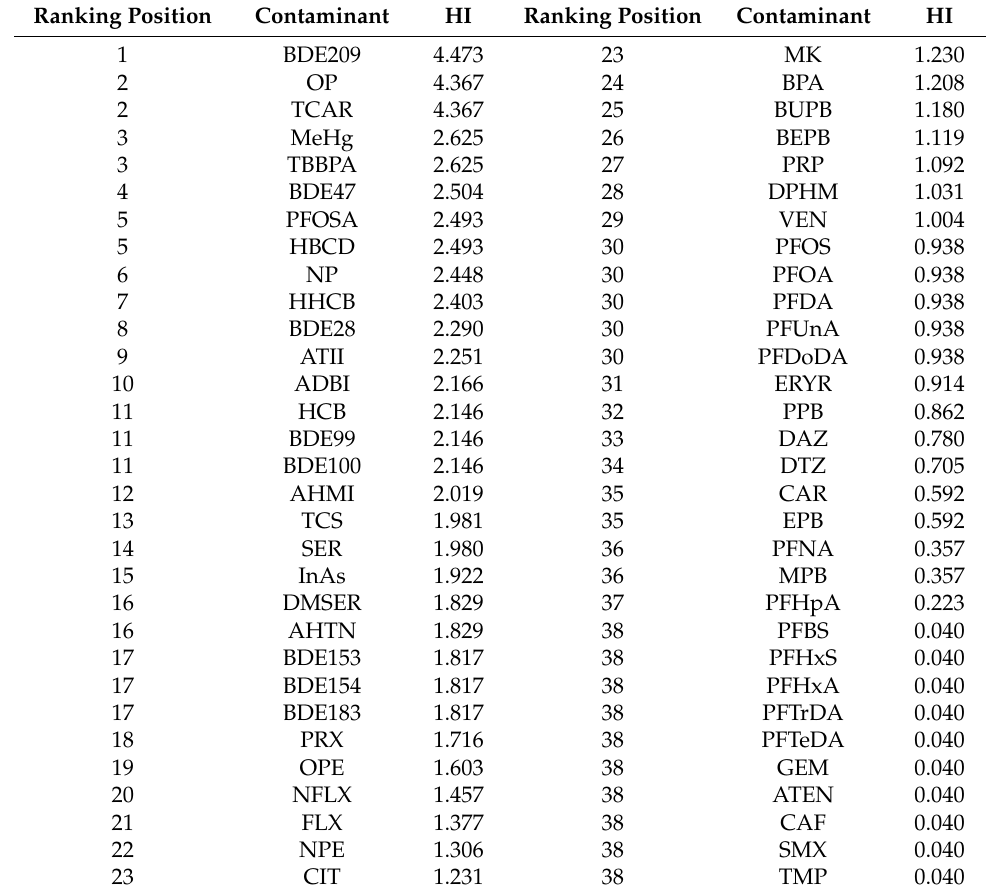
Table 5. Hazard Index (HI) developed for the 62 compounds by means of the Kohonen’s